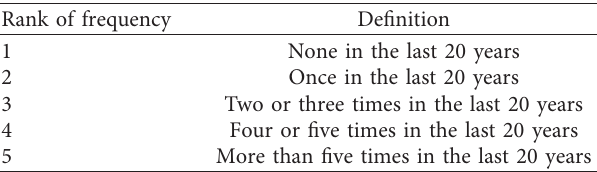
Table 3: Ranking the hazards according to its magnitude. Rank of magnitude